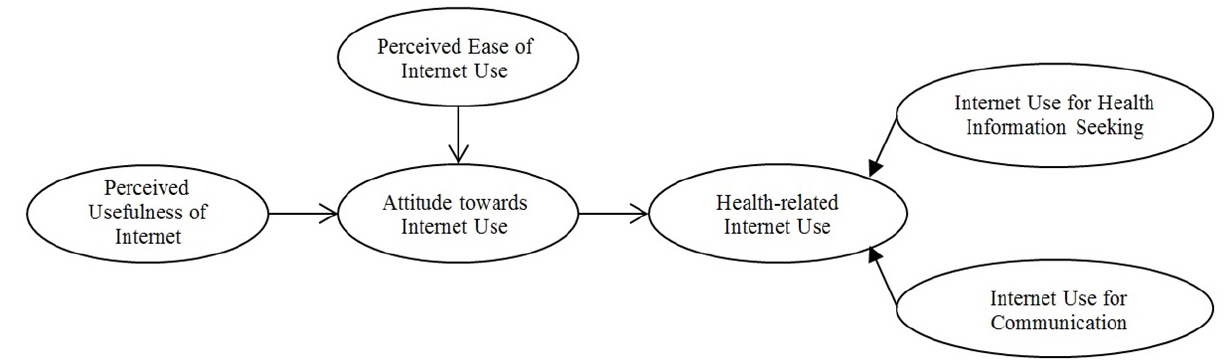
Figure 2. Hypothesized model based on Technology Acceptance